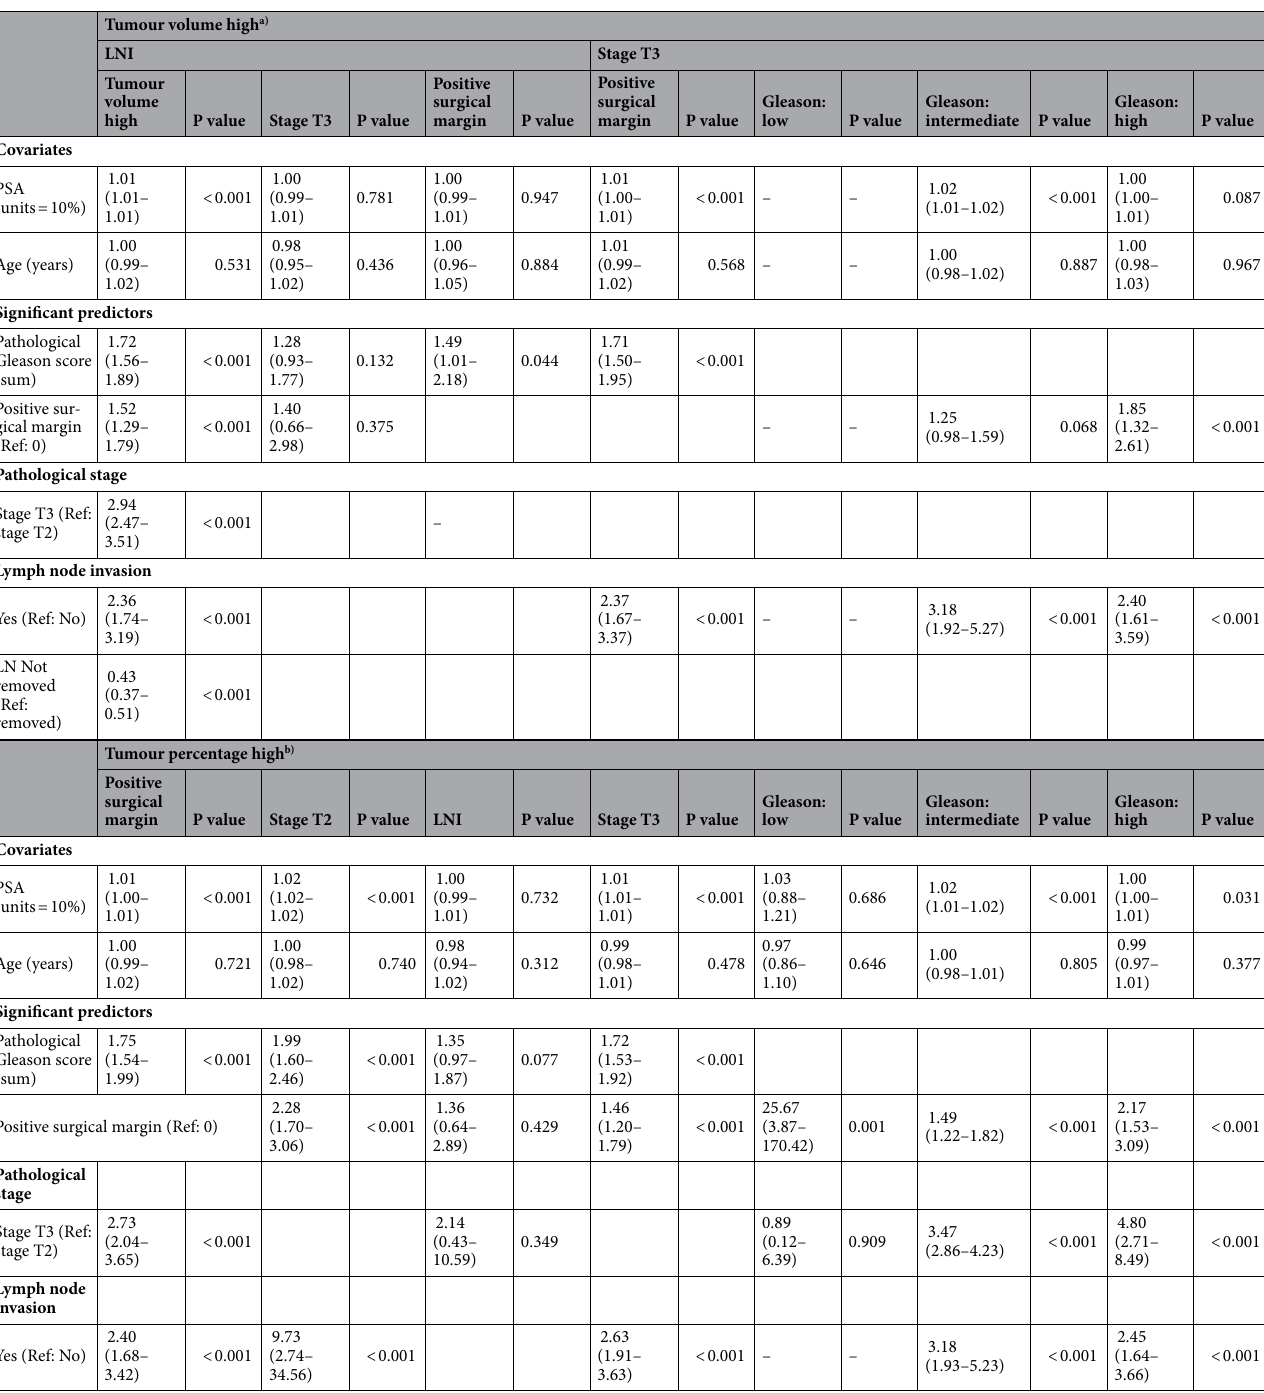
Table 4. Cox proportional hazards analyses of significant predictors, covariates on biochemical recurrence. LN not removed (Ref: